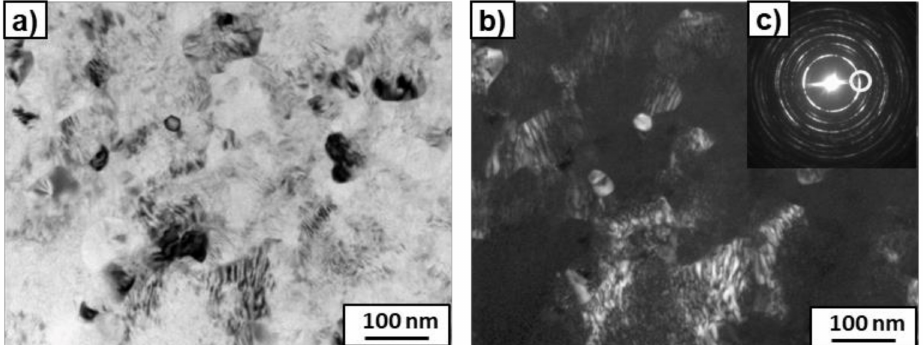
Figure 6. TEM micrographs of the Ti–3wt.% Nb alloy after HPT deformation and pre-annealing at 600 ◦ C. Bright field ( a ), dark field ( b ) images and SAED pattern ( c ). The ring shows the position of the objective aperture for obtaining the dark-field image.